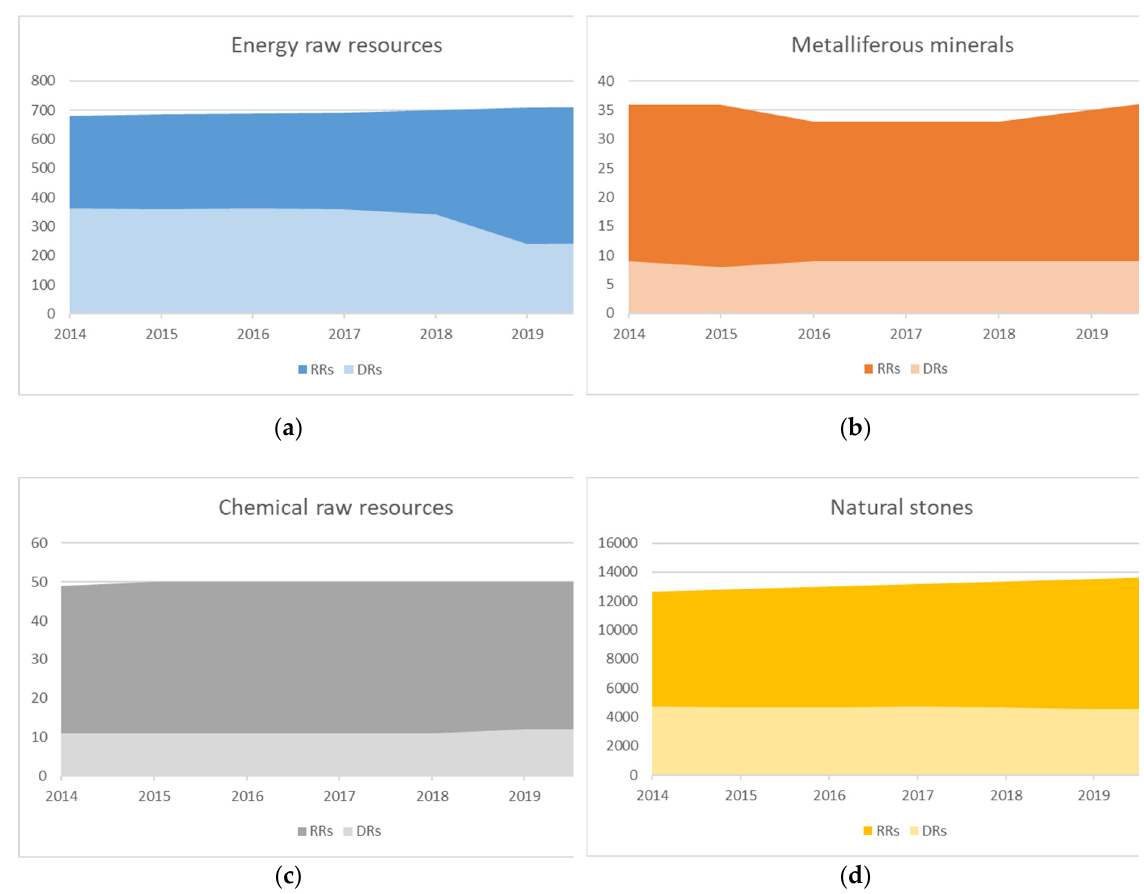
Figure 1. Comparison of the level of real resources (RRs) and deposit resources (DRs) for four groups of mineral resources in Poland (in millions of tons): ( a ) raw energy resources; ( b ) metalliferous minerals; ( c ) raw chemical resources; ( d ) natural stones.